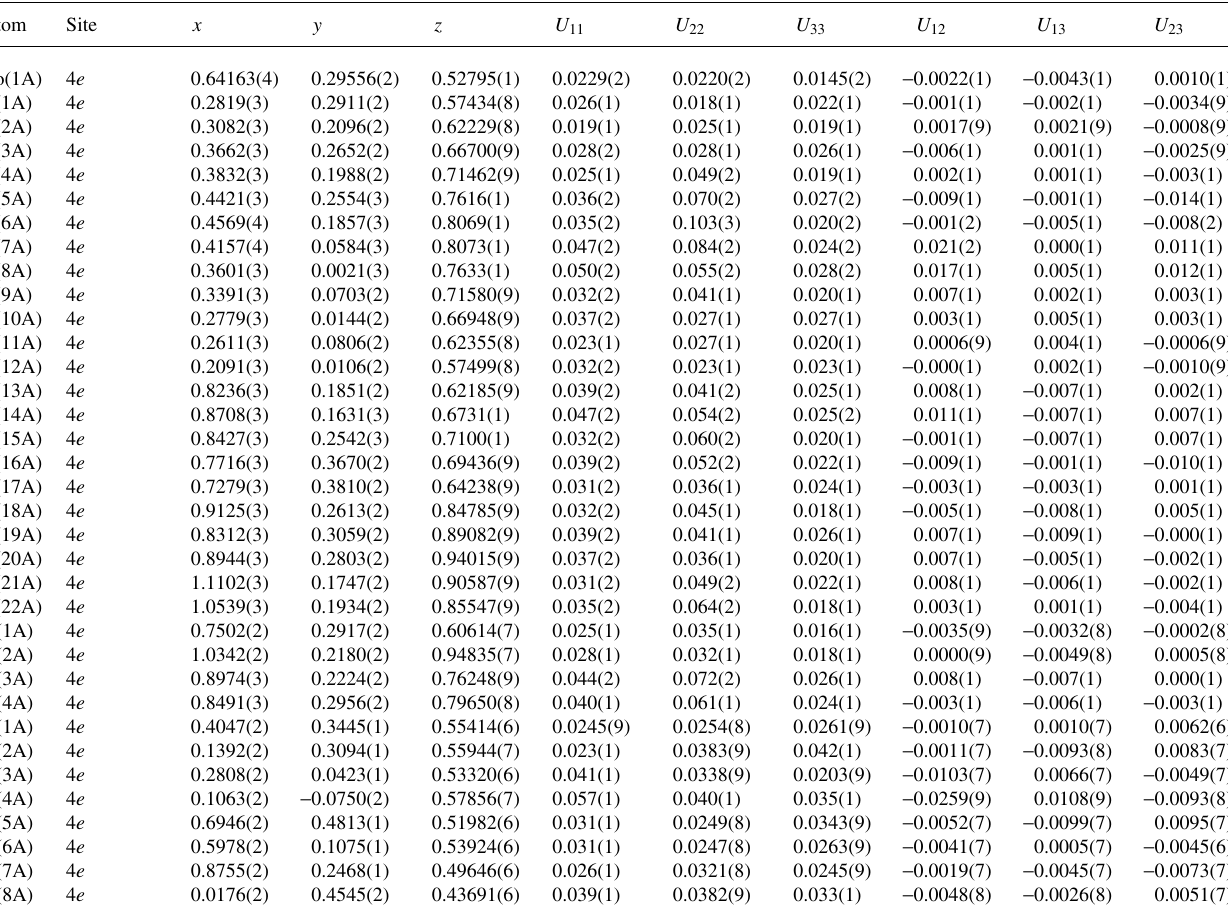
Table 3. Atomic coordinates and displacement parameters (in Å 2 ) .